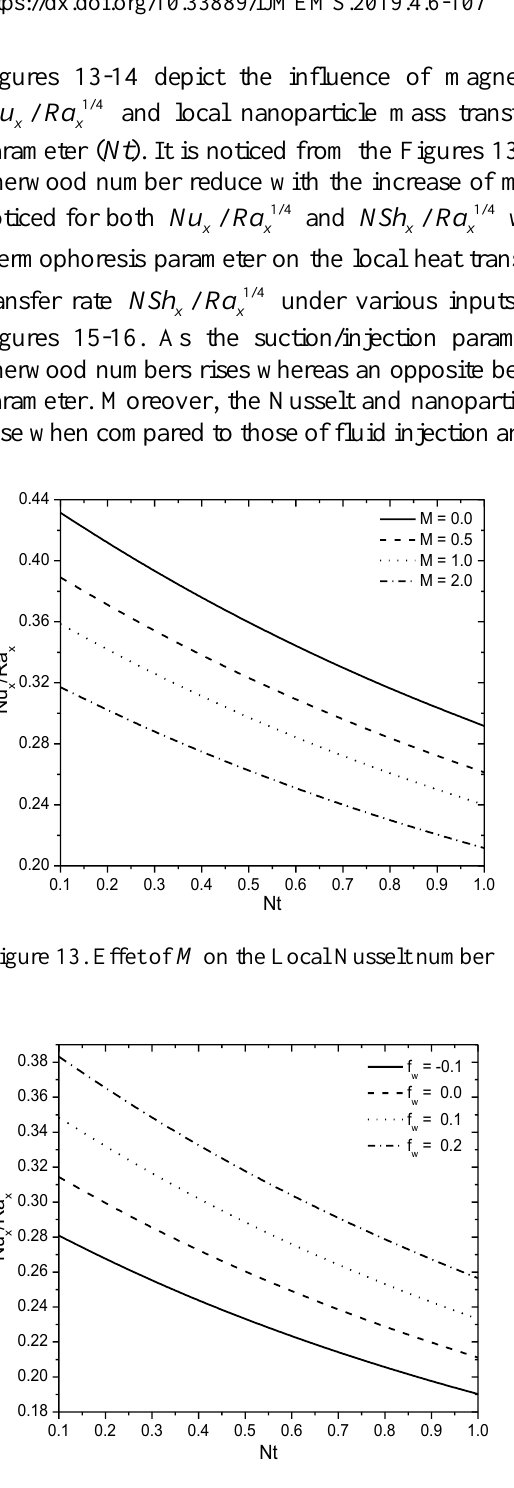
Figure 15. Effet of f w on the Local Nusselt number Figure 16. Effet of f w on the Local nanoparticle